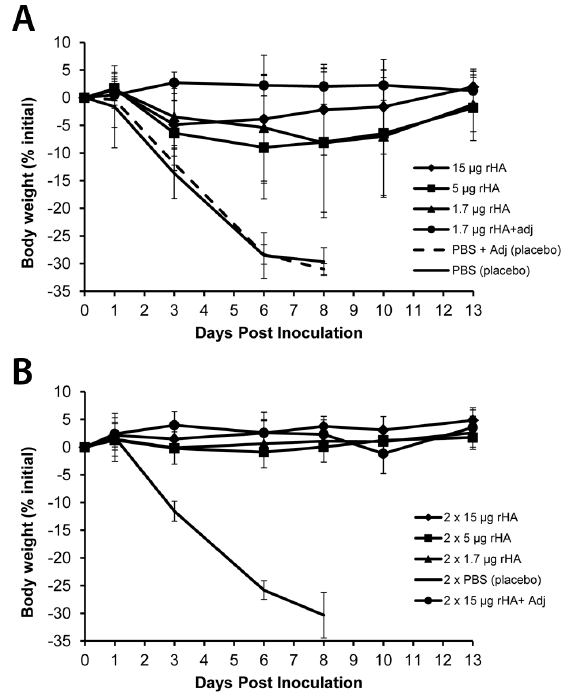
Figure 4. Effect of vaccination dosage and regimen on body weight after inoculation. Mice were given a single vaccination (A) or two doses 21 days apart (B), challenged and their body weight monitored for 14 days. N=10 mice per group.